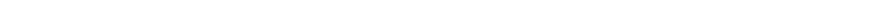
Table 1. Criteria 1: Genes (n = 11) in major blood pressure regulatory pathways associated with the blood pressure response to exercise. Two searches were conducted on 05 / 11 / 2017 and a total of 321 records were